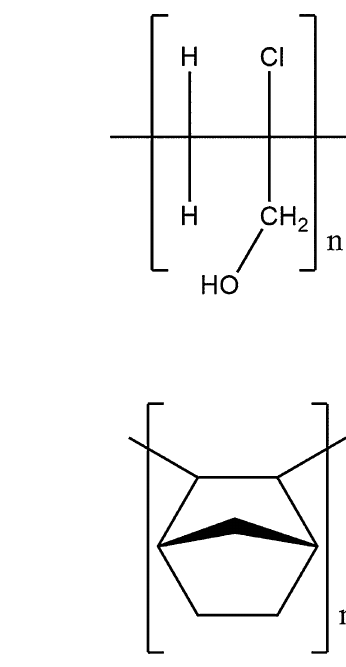
Figure 6. The scheme of oligomerization reaction ( A ) for 2-chloro-2-propen-1-ol and ( B ) for norbornene, where n denotes number of mers in the oligomer